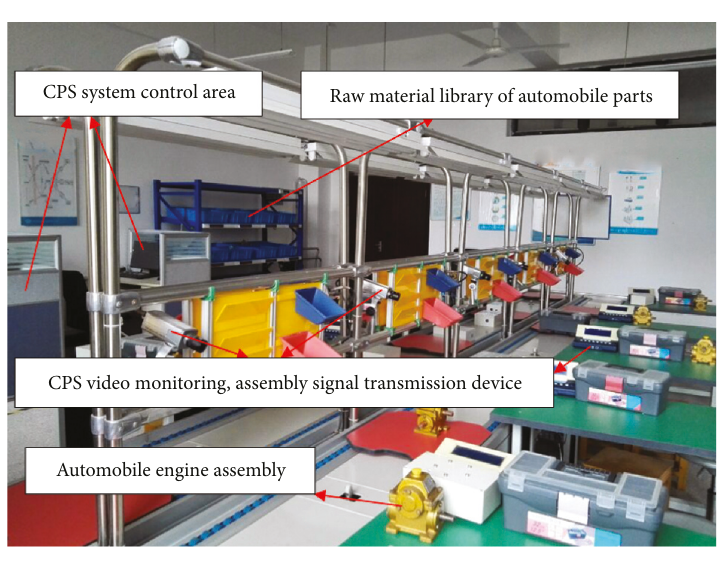
Figure 3: Simulation platform of mixed assembly line for industry 4.0